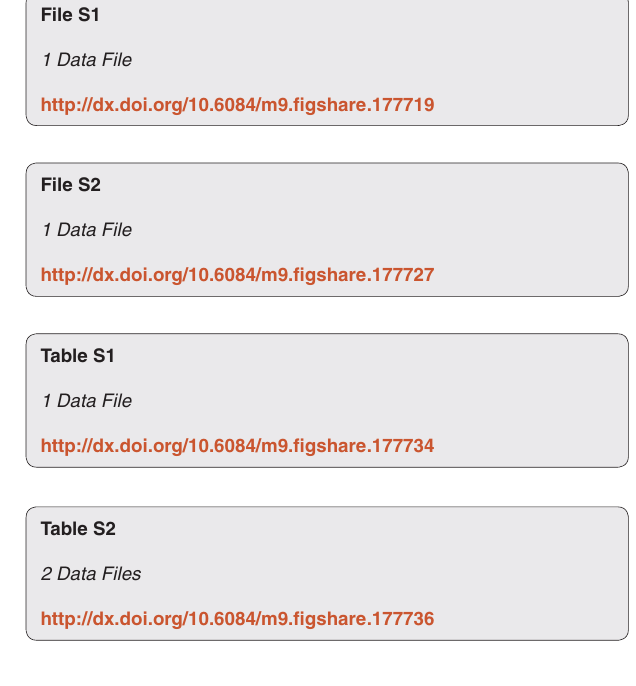
Table S1. Orthologs clusters identification among SIs from V. chol- erae and V. mimicus genomes. These clusters were identified using the pangenome analysis pipeline 10 , strains without genes in the cluster are marked with “-”. Table S2. Clusters involved with indel or mutation events. The 1 st column is the Cluster ID, which is consistent with the ID in Table S1. The 2 nd column is the cluster conservation of current cluster. The 3 rd column is the variation position, which counts according to the alignment result of protein sequences in this cluster. For indel events, the position is an integer. For synonymous mutation and non synonymous mutation, the position is a floating number, in which the integer part marks the position of the amino acid in